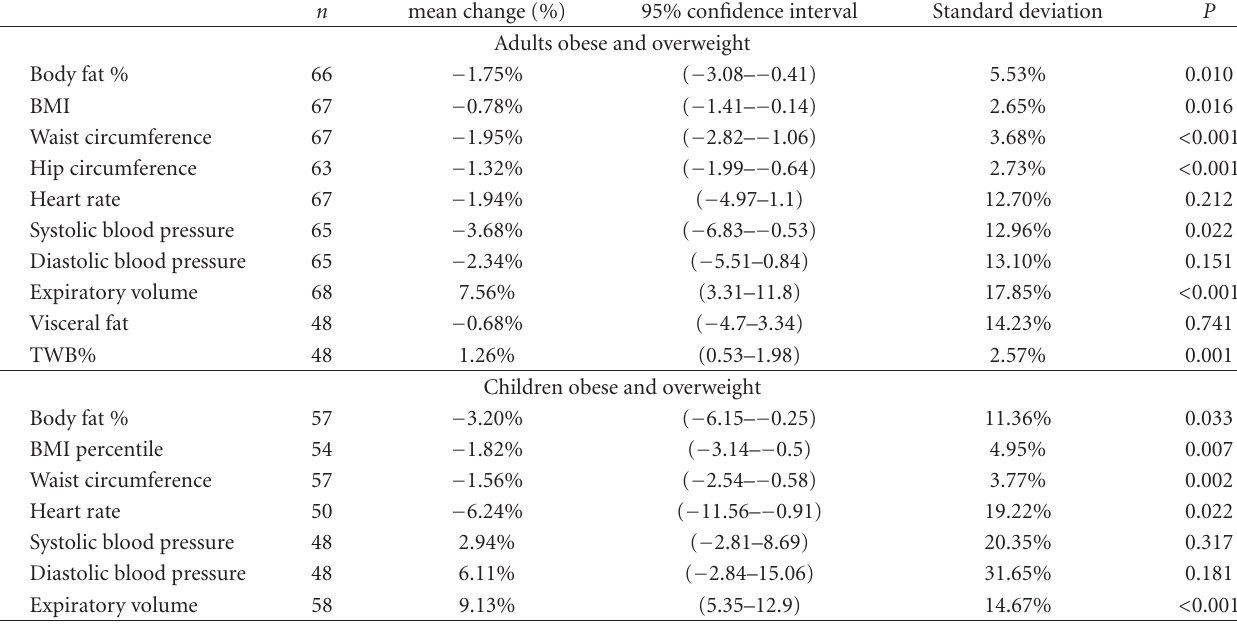
Table 4: Physiological changes, comparing baseline with course end measures for overweight or obese